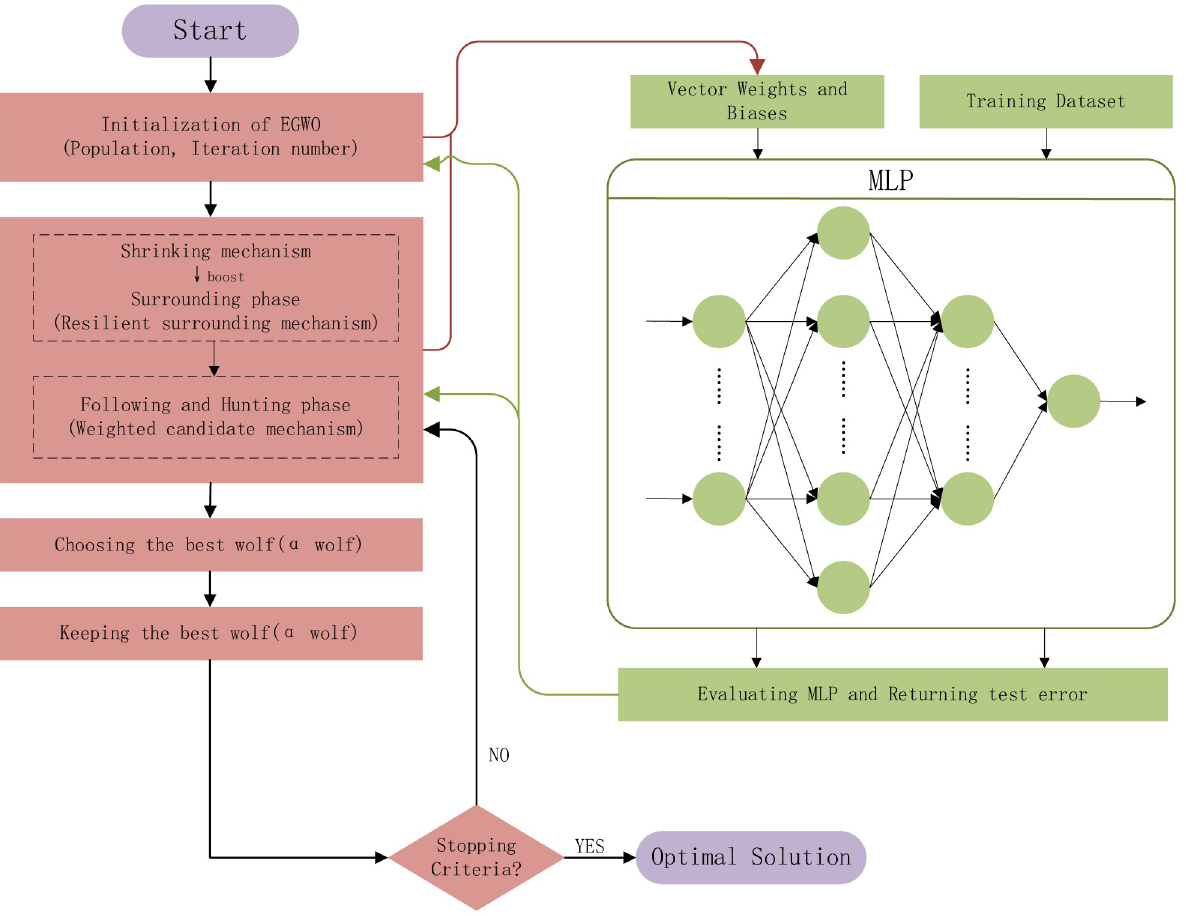
Fig 4. Process of Elastic Grey Wolf Optimization algorithm (EGWO) training